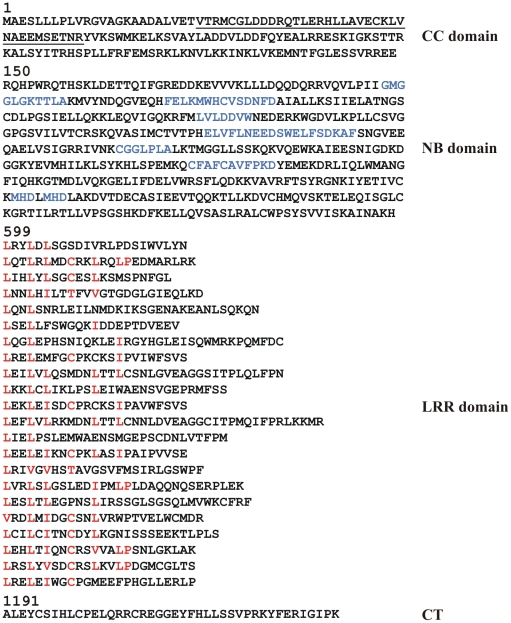
RDG2A protein sequence.The predicted coiled-coil (CC) domain is underlined. Motifs conserved in the NB region of NB-LRR proteins are in blue, and are (in order): P-loop, RNBS-A, Kinase 2, RNBS-C, GLPL, RNBS-D and MHD. Amino acids conforming to the cytoplasmic LRR consensus LxxLxLxx(C/N/T)xxLxxLxxLP are in red. CT denotes the RDG2A C-terminal region.